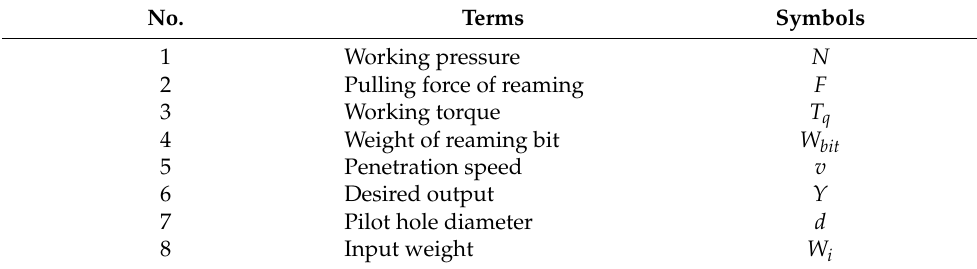
Table 1. Nomenclature of the